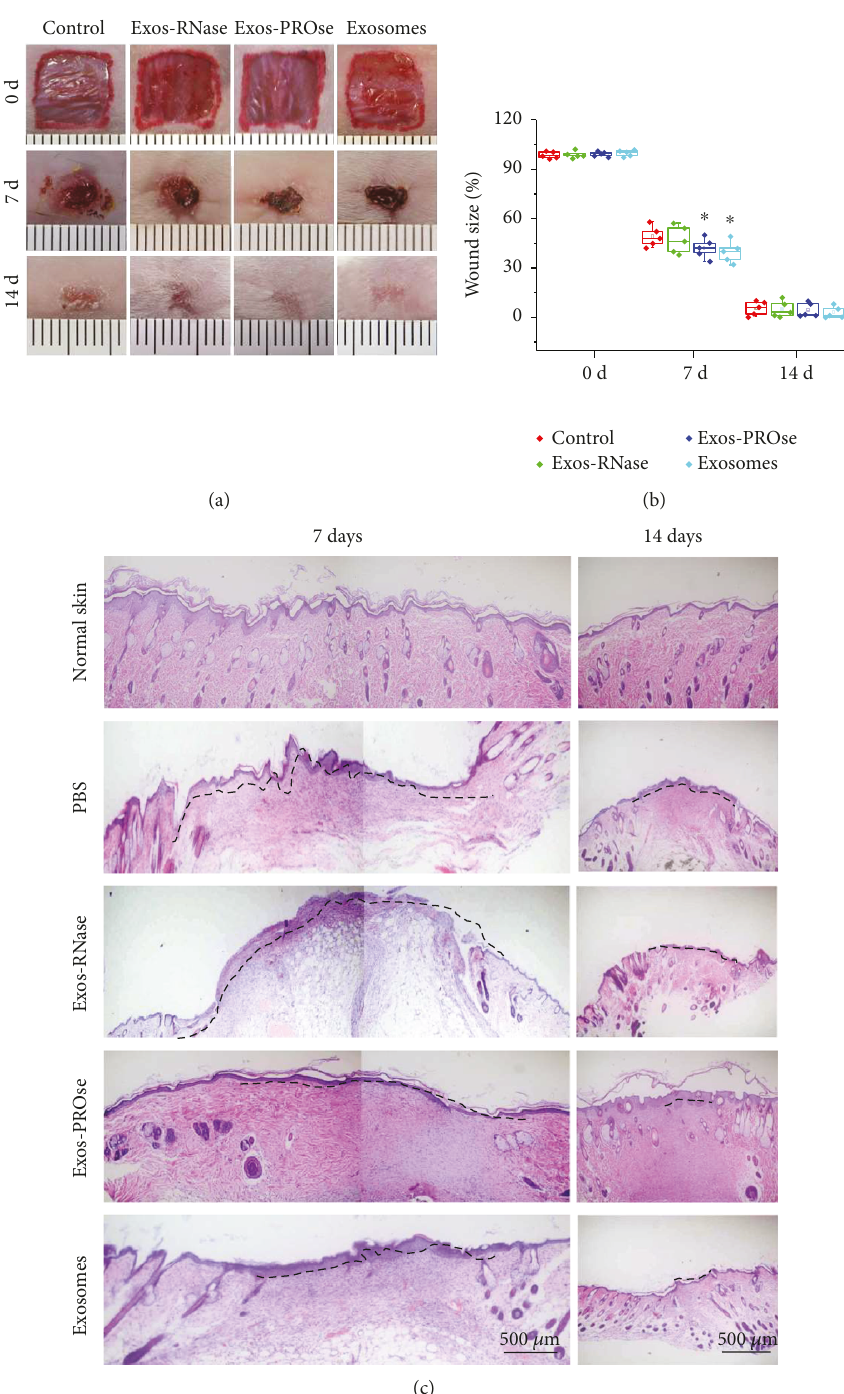
Figure 5: Wound closure assay on mice treated with hAEC-Exos. (a) Representative photographs of full-thickness excisional wounds treated with PBS, hAEC-Exos, Exos-PROse, or Exos-RNase. (b) Quantitative analysis of wound healing in each group ( ∗ P < 0 05 , n = 5 ). (c) H&E staining of wounded skin sections in di ff erent groups on days 7 and 14 postwounding. Scale bar =500 μ m ( n = 5